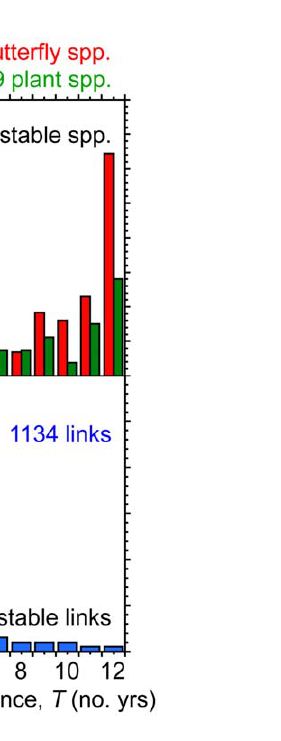
Figure 2. Variation in temporal persistence of species and links. Frequency distributions of temporal persistence T (no yrs observed) for species ( A ) and links ( B ). Sporadic species and links have a T of 1–2(-5) years, i.e. observed , 20% of the time, whereas stable species and links have a T of (9-)11–12 years, i.e. observed . 80% of the